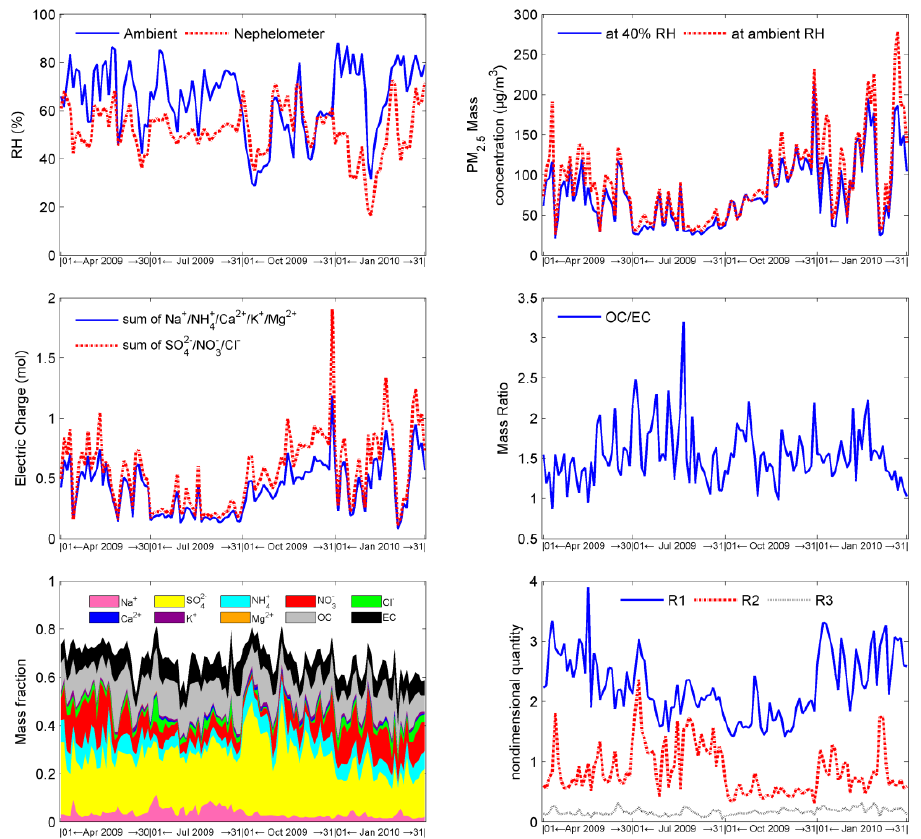
Figure 2 Variations of RH, PM mass, ions ’ mass, ratio of OC to EC, 349 Fig. 2. Temporal variations of RH, PM 2.5 2 . 5 mass, molarity of electric charge, ratio of OC to EC, components’ mass fraction and characteristic values ( R 1 , R 2 , R 3